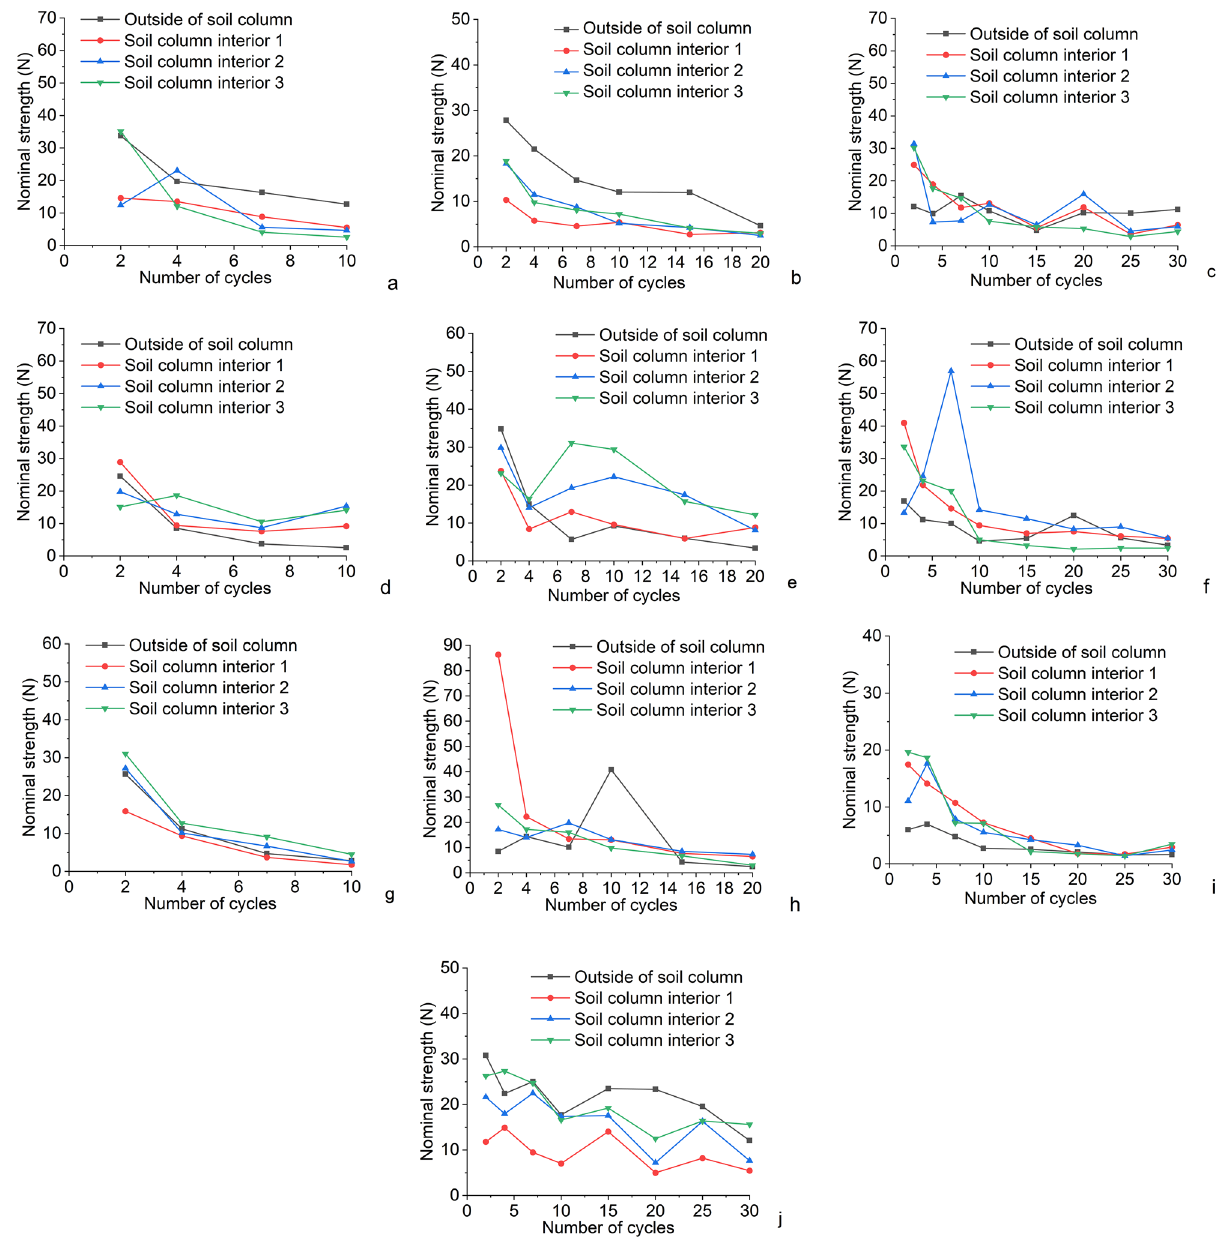
Figure 5. Change of nominal strength of each soil column ( a ) Experimental group 1; ( b ) Experimental group 2; ( c ) Experimental group 3; ( d ) Experimental group 4; ( e ) Experimental group 5; ( f ) Experimental group 6; ( g ) Experimental group 7; ( h ) Experimental group 8; ( i ) Experimental group 9; ( j ) Experimental group